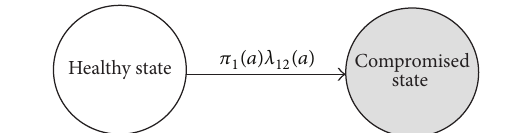
Figure 3: CSP under attack.